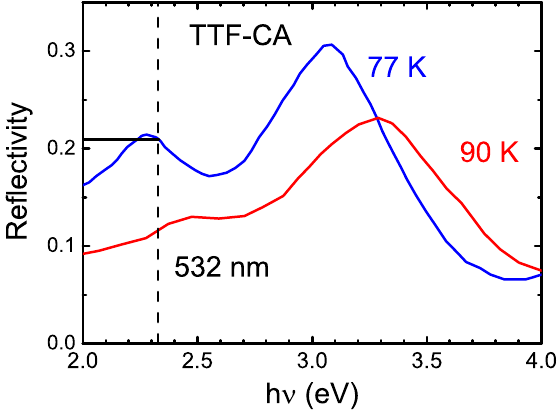
Figure 20. Reflectivity of TTF-CA in the ionic (blue) and neutral (red) phase. The dashed line marks the photon energy of the exciting laser. (Adapted from